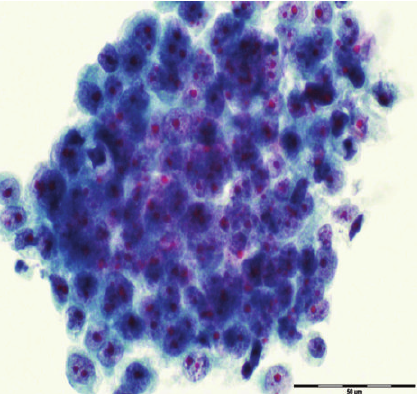
Figure 3: Fine needle aspiration of the thyroid mass FNA, ThinPrep shows clusters of cancer cells with large nuclei and prominent nucleoli, consistent with metastatic lung adenocarcinoma.